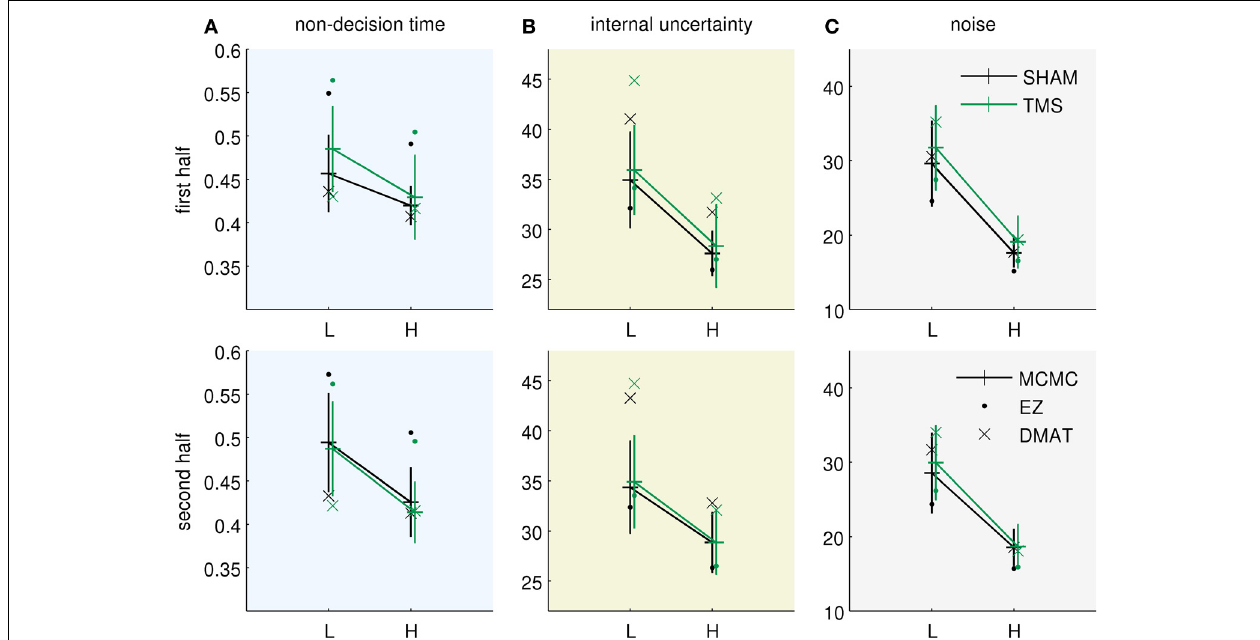
FIGURE 3 | Bayesian parameters resulting from using three different inference methods (EZ, DMAT, MCMC). EZ—EZ method of Wagenmakers et al. (2007), DMAT—fit using diffusion model analysis toolbox of Vandekerckhove and Tuerlinckx (2007) and MCMC—direct Markov chain Monte Carlo fitting of Bayesian model. The parameters of the pDDM fits were translated to the Bayesian model. The data were obtained from Philiastides et al. (2011). L—low evidence (high noise) condition, H—high